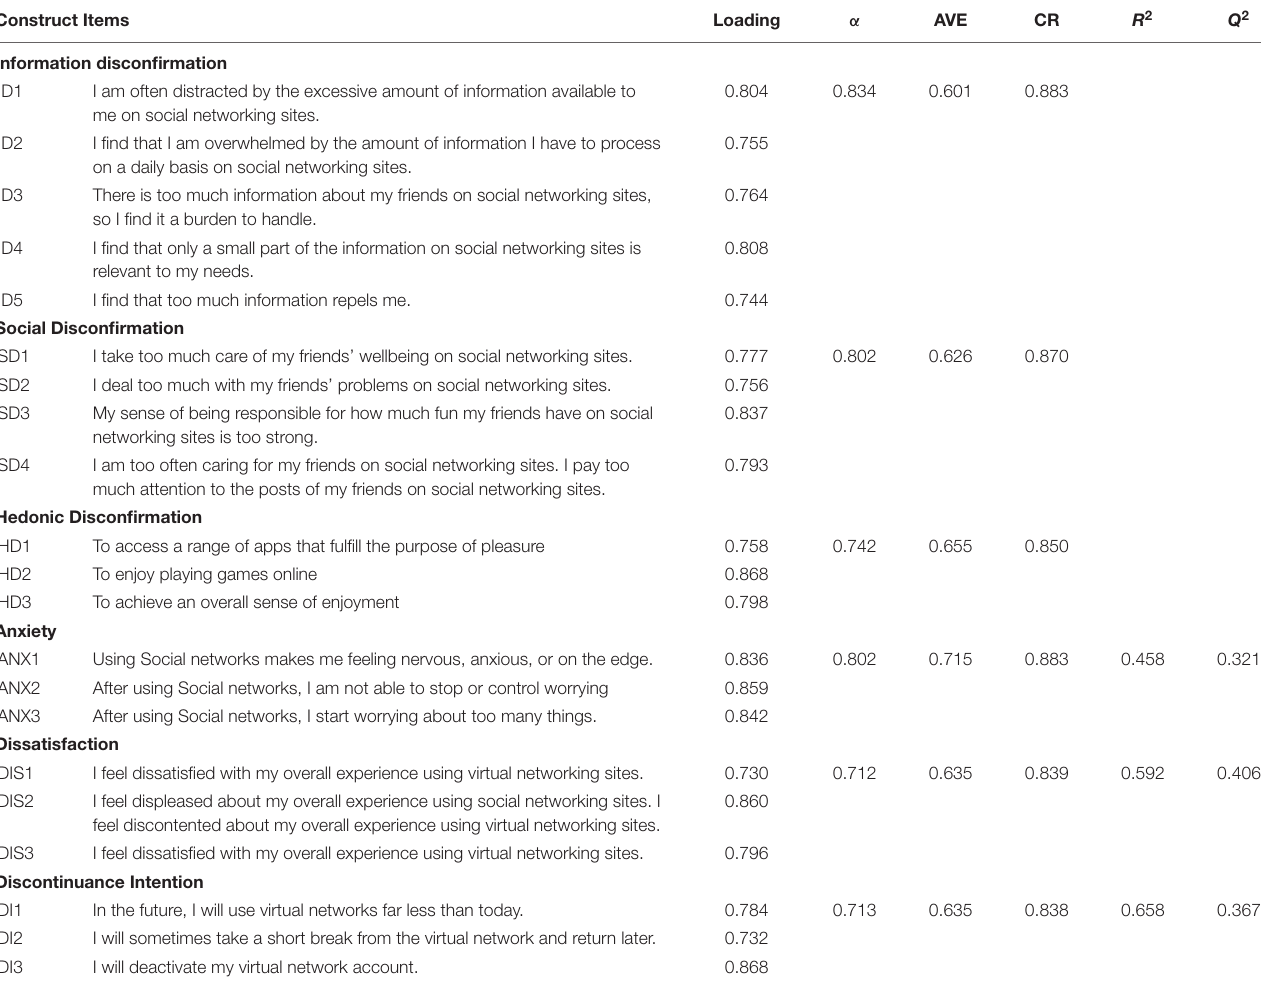
TABLE 1 | Present construct items, factor loading, AVE, Cronbach’s Alpha, CR, R 2 and Q 2